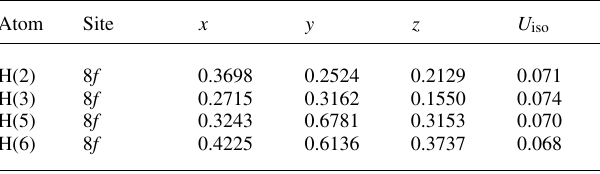
Table 2. Atomic coordinates and displacement parameters (in Å 2 )